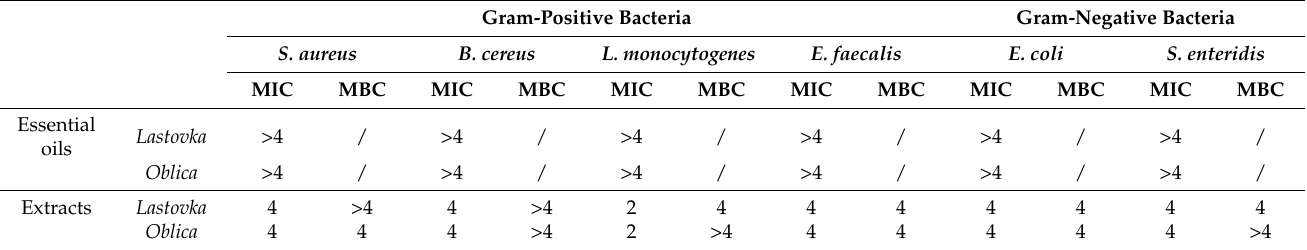
Table 4. Results of the minimal inhibitory concentration (mg/mL) and minimal bactericidal concen- tration (mg/mL) of the olive vegetative bud essential oil and extracts against foodborne pathogens ( n =